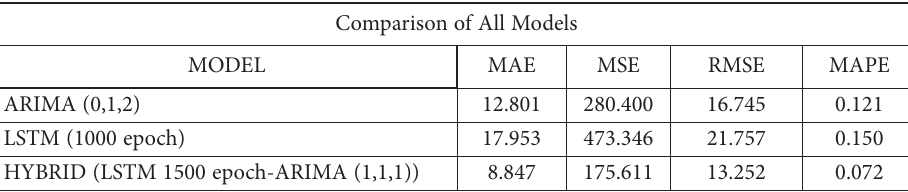
Table 5. Comparison of all models